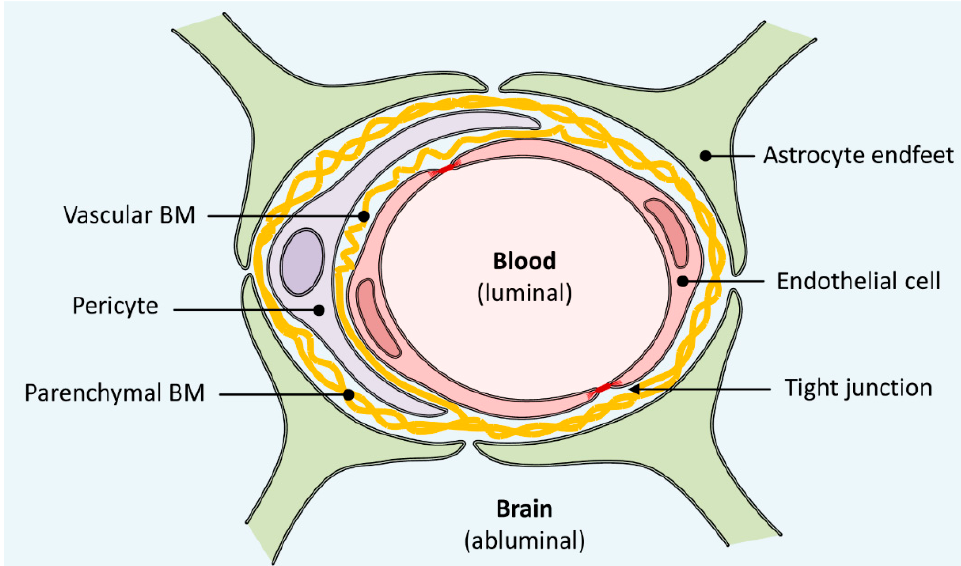
Figure 1. Anatomical structure of the blood–brain barrier (BBB). The wall of all brain capillaries is formed by a thin monolayer of specialized brain microvascular endothelial cells joined together by tight junctions, which act as a physical, transport and metabolic barrier. They are surrounded by a vascular basement membrane (BM), pericytes, a parenchymal BM and astrocyte endfeet, all of which directly or indirectly contribute to the barrier function of the BBB.